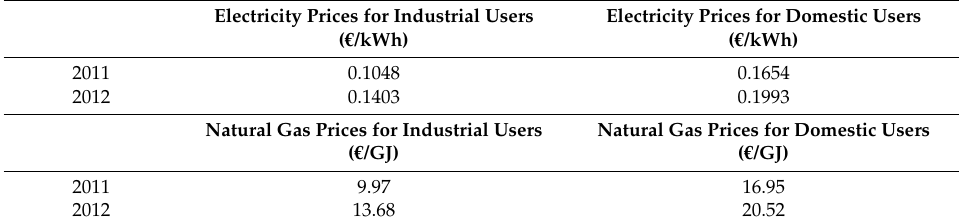
Table 3. Electricity and natural gas prices for industrial and domestic